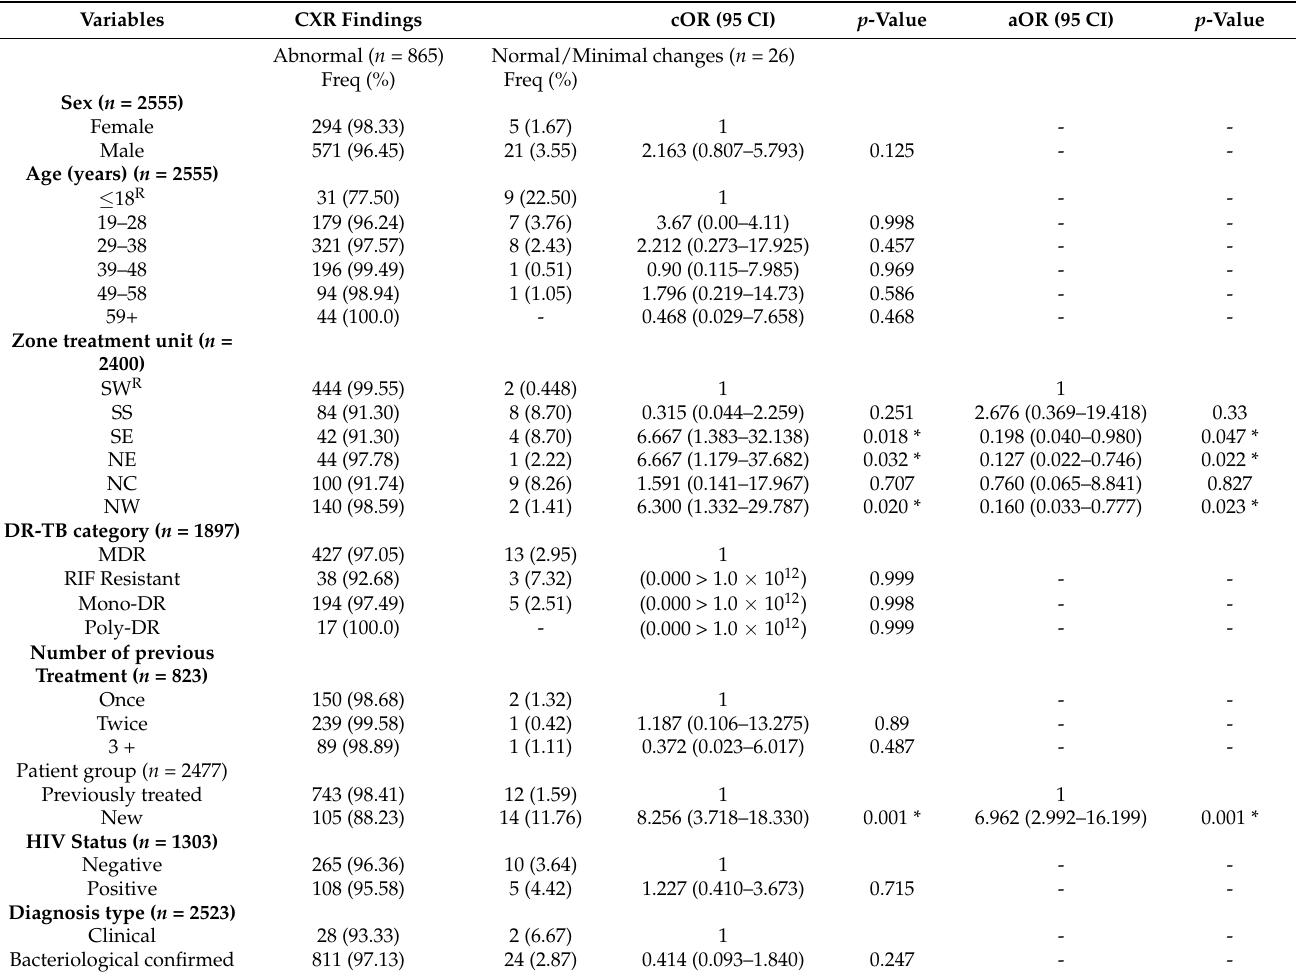
Table 2. Pattern of Chest X-ray findings at presentation among Drug-Resistant Tuberculosis cases in Nigeria (Bivariate and Multivariate Logistic Regression) ( n =